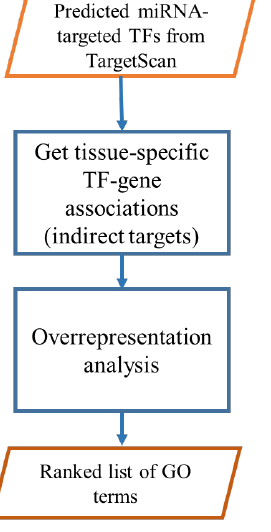
Figure 2. Pipeline of our miRNA GO enrichment analysis